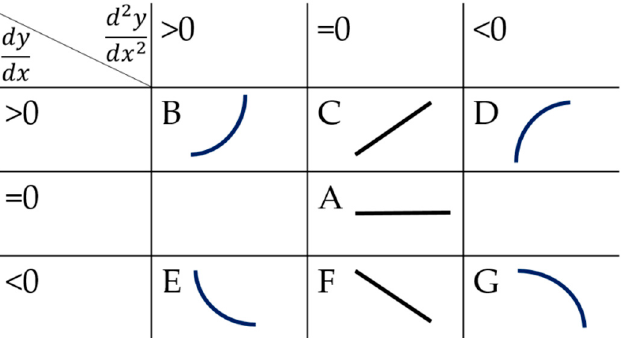
Figure 1. QTA knowledge base based on derivative. A~G are seven different primitives derived from the relationship between the derivatives and zero.